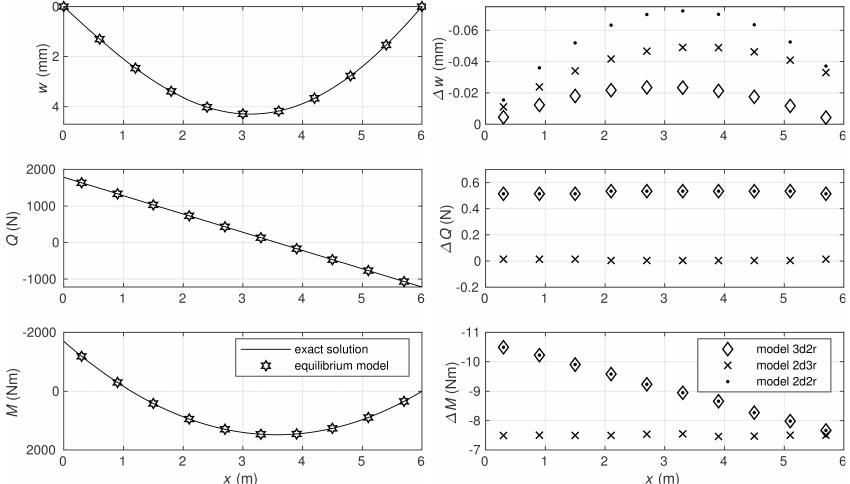
Figure 6. Comparison of deflections at nodes and section forces at central points of elements.